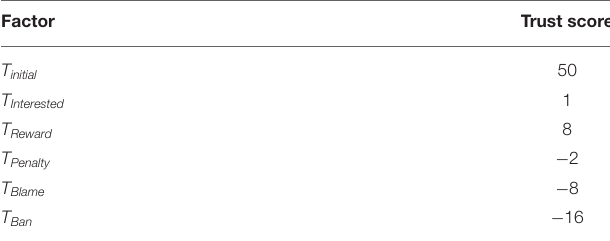
TABLE 1 | List of trust score corresponding to different factors for an FL-IoT environment. Factor Trust score T initial 50 T